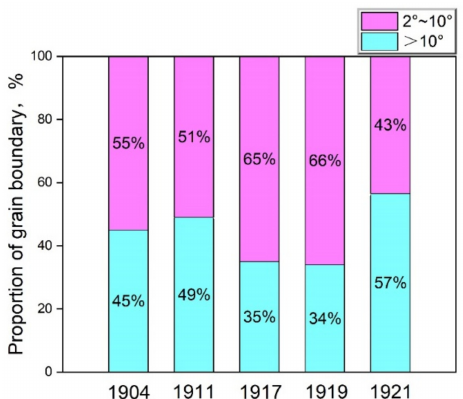
Figure 5. Proportion diagram of grain boundary for the rail steels.